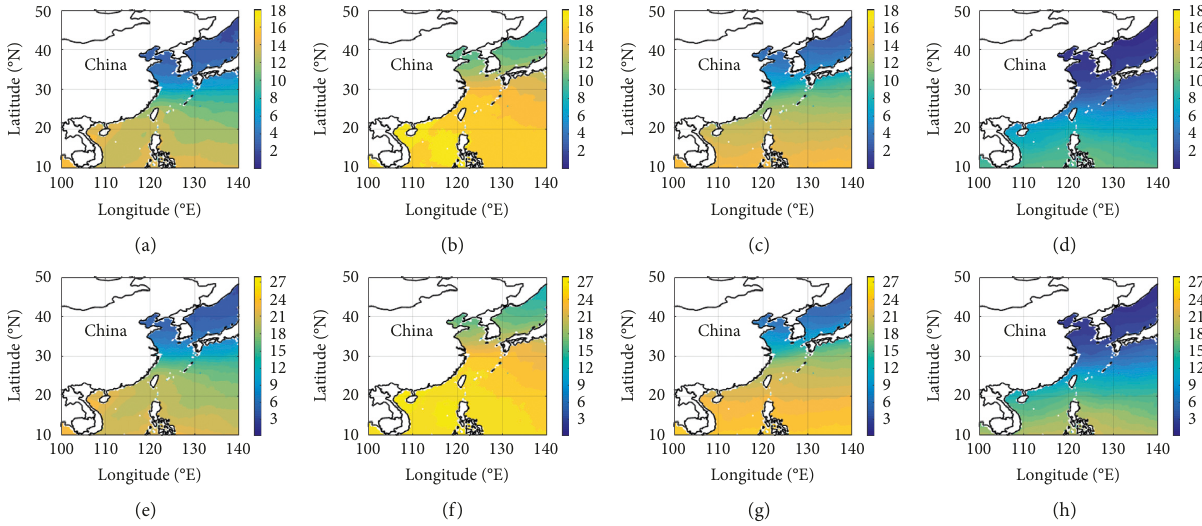
Figure 7: (a–d) Means and (e–h) STDs of PWV derived from the GMI 3-day composites (2014–2017) for different seasons. (a) Mean of PWV Spring. (b) Mean of PWV Summer. (c) Mean of PWV Autumn. (d) Mean of PWV Winter. (e) STD of PWV Spring. (f) STD of PWV Summer. (g) STD of PWV Autumn. (h) STD of PWV